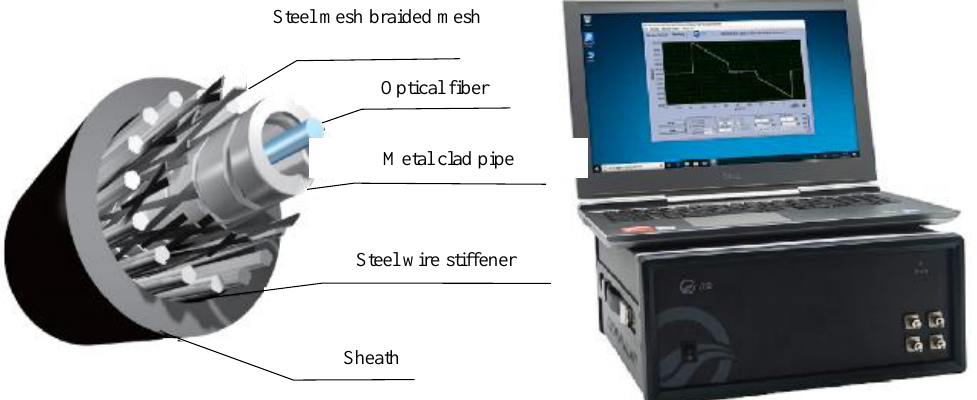
Figure 1. The photo of temperature measurement fiber and temperature analyzer. The optical fiber was heated using 8 W power. During the heating process, the temperature change at different locations and depths of the enclosure structure were obtained. Then the data were analyzed to obtain the variation curve of fiber temperature with depth and location.